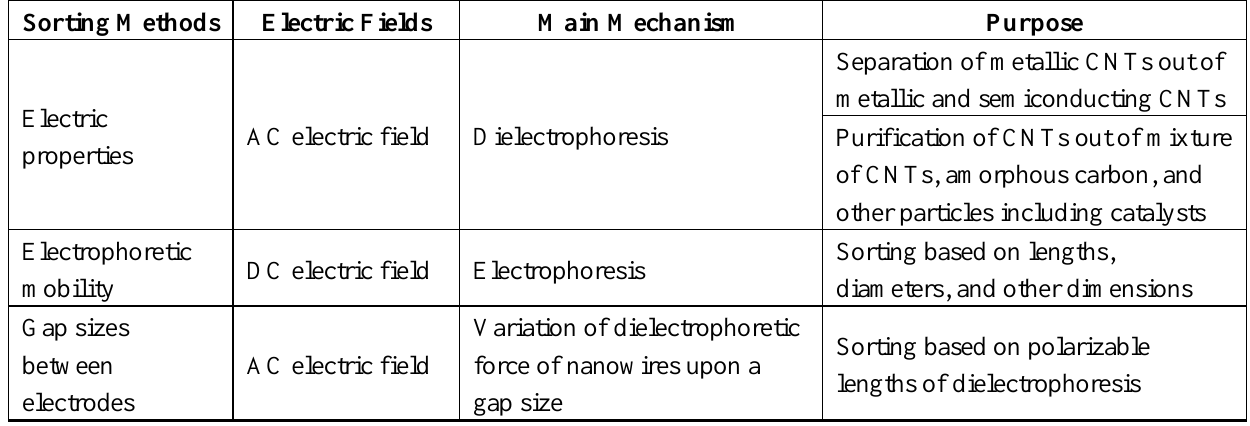
Table 3. Summary of selected assembly methods using electric